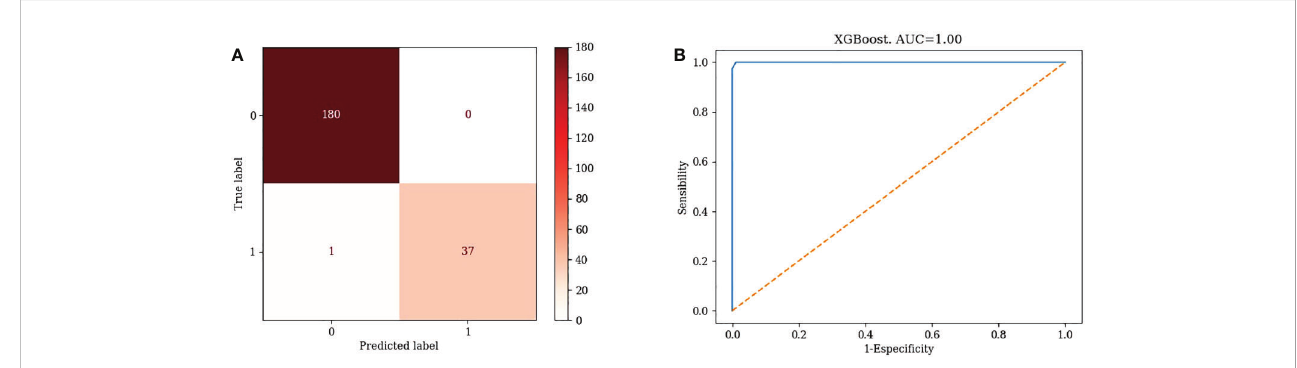
FIGURE 5 Confusion matrix and ROC curve of XGBoost